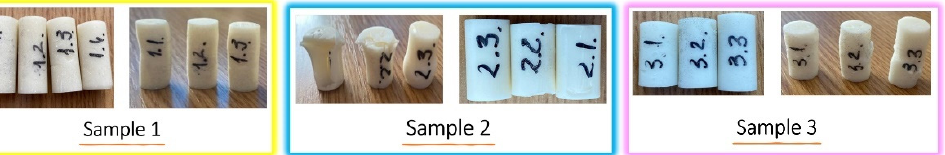
Figure 8. Images of the specimens before and after the compressive strength test (before compression—left; after compression—right.